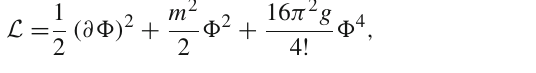
(cid:6) ε versus a 1 as 8